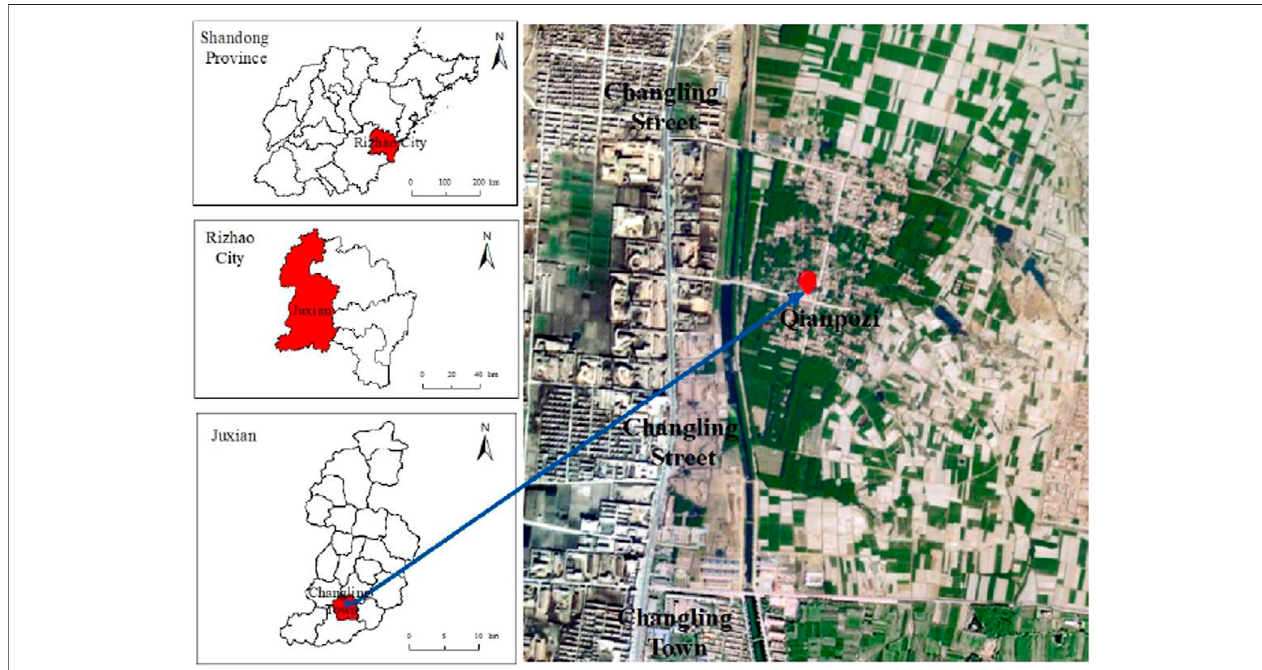
FIGURE 2 | Location of Qianpozi